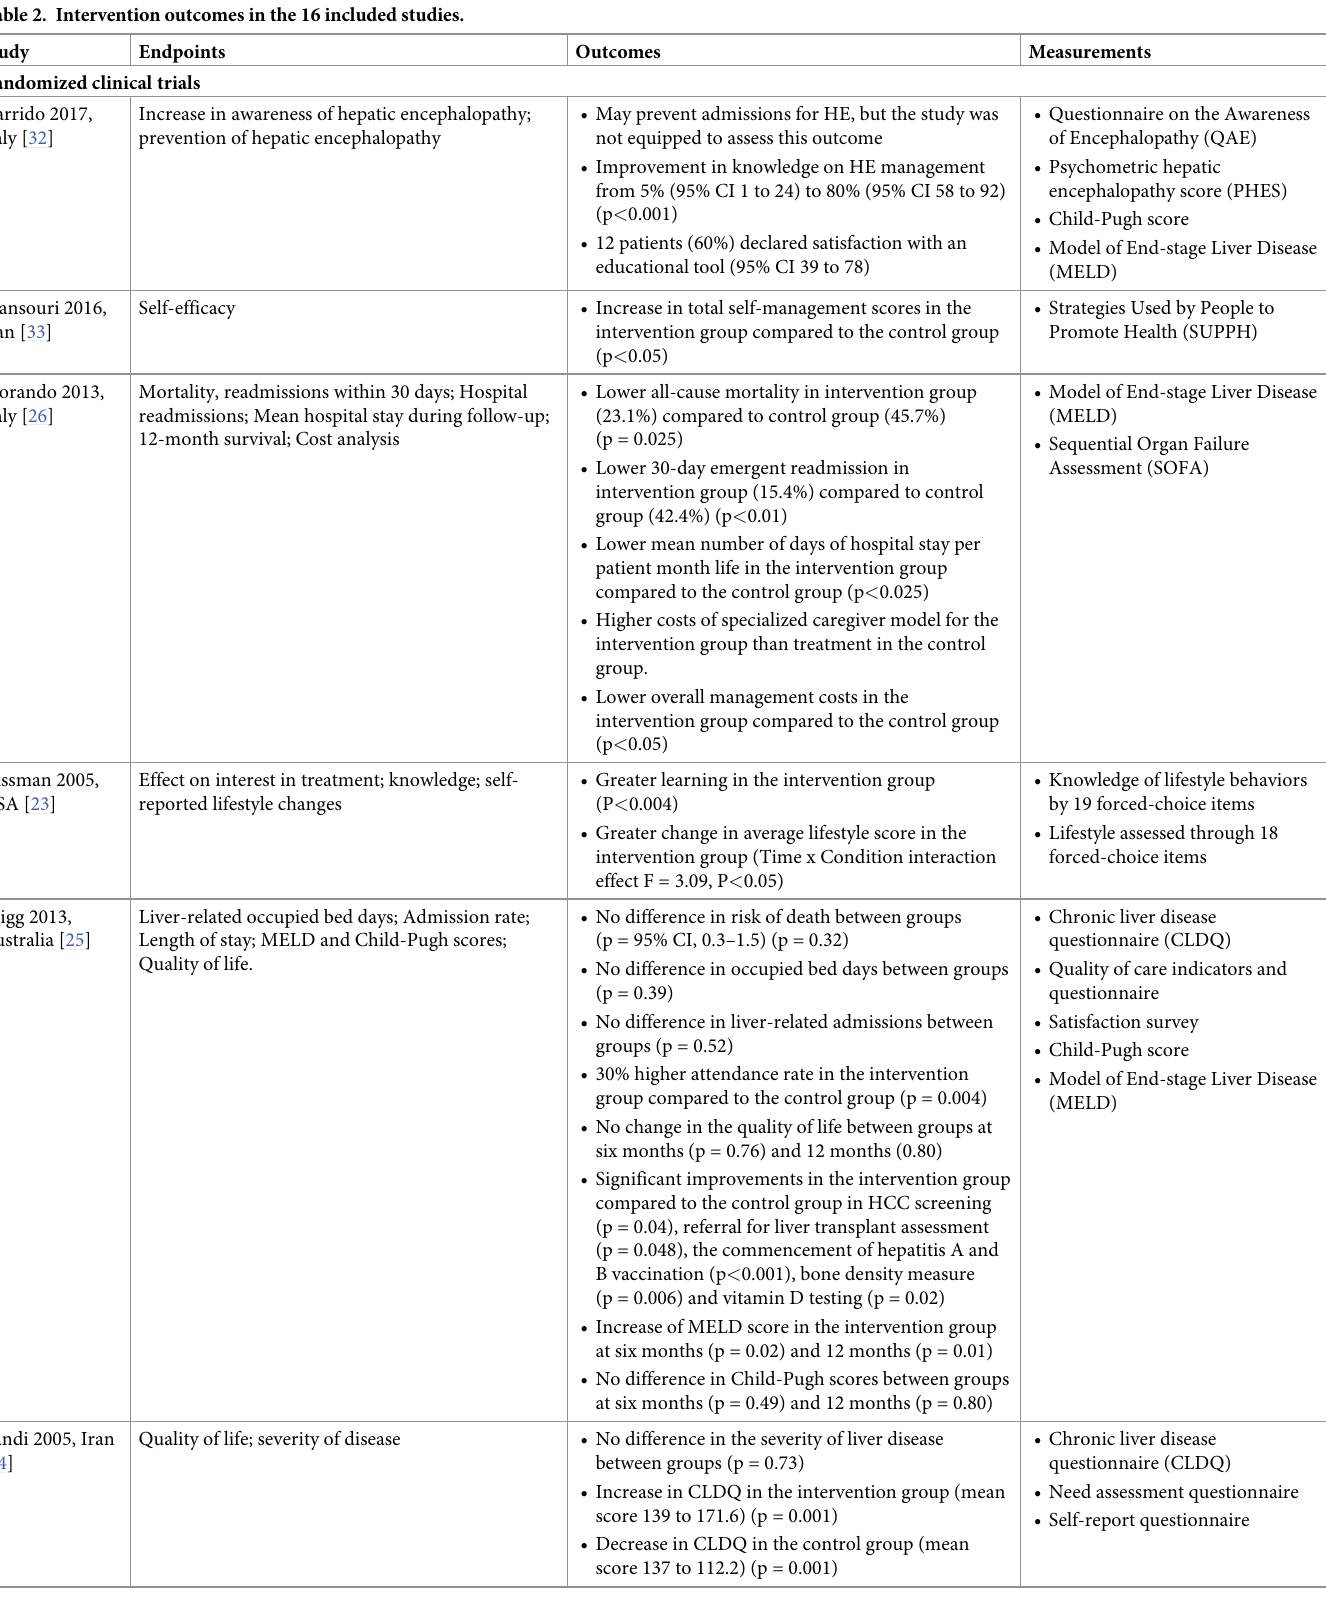
Table 2. Intervention outcomes in the 16 included